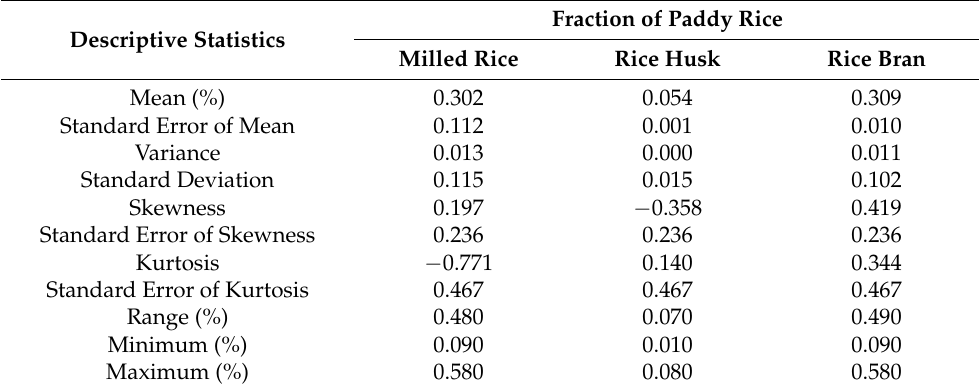
Table 3. Descriptive statistics for the β -glucan content of the milled rice, rice husk, and rice bran fractions of paddy-rice samples with the exceptional SN, JKC, and SMJ cultivars.